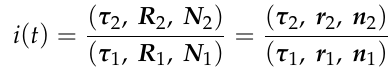
Figure 20. Test results of transmission errors after translation.